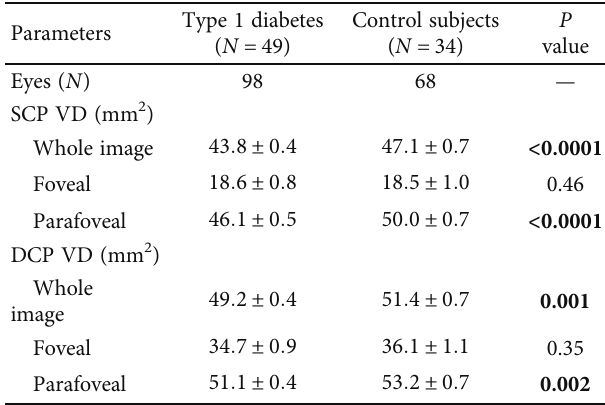
Table 2: OCTA parameters measured in patients with type 1 diabetes and control